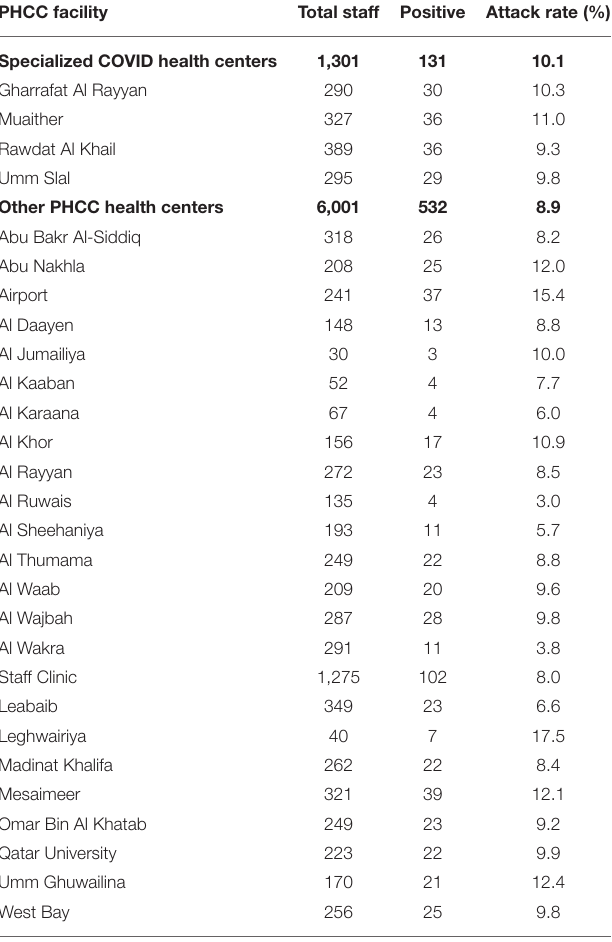
TABLE 4 | Attack rate among staff in various health